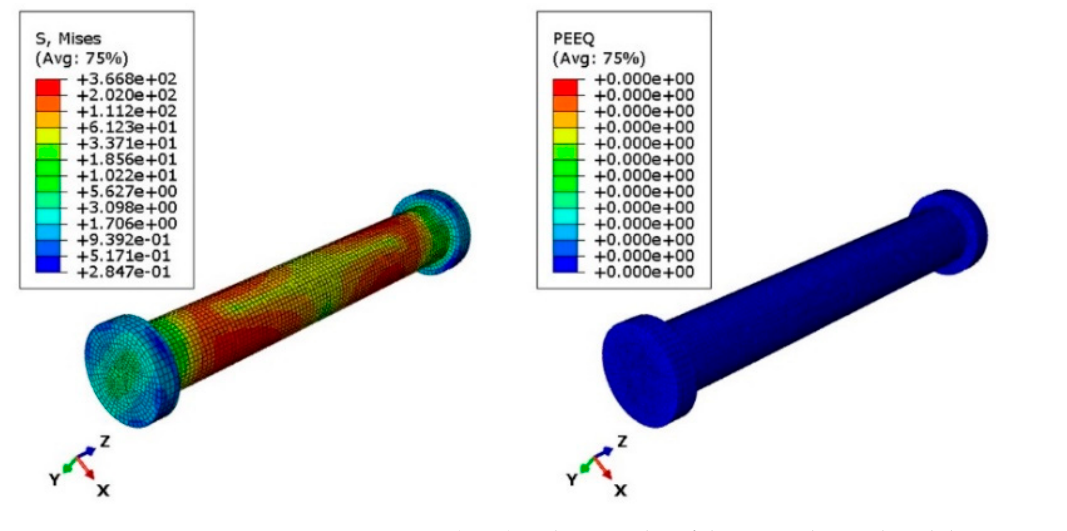
Figure 40. Von Mises stress (MPa) and PEEQ plot of the pin at the predicted design capacity using the EN 1993-1-8 equation (P = 8070 N).